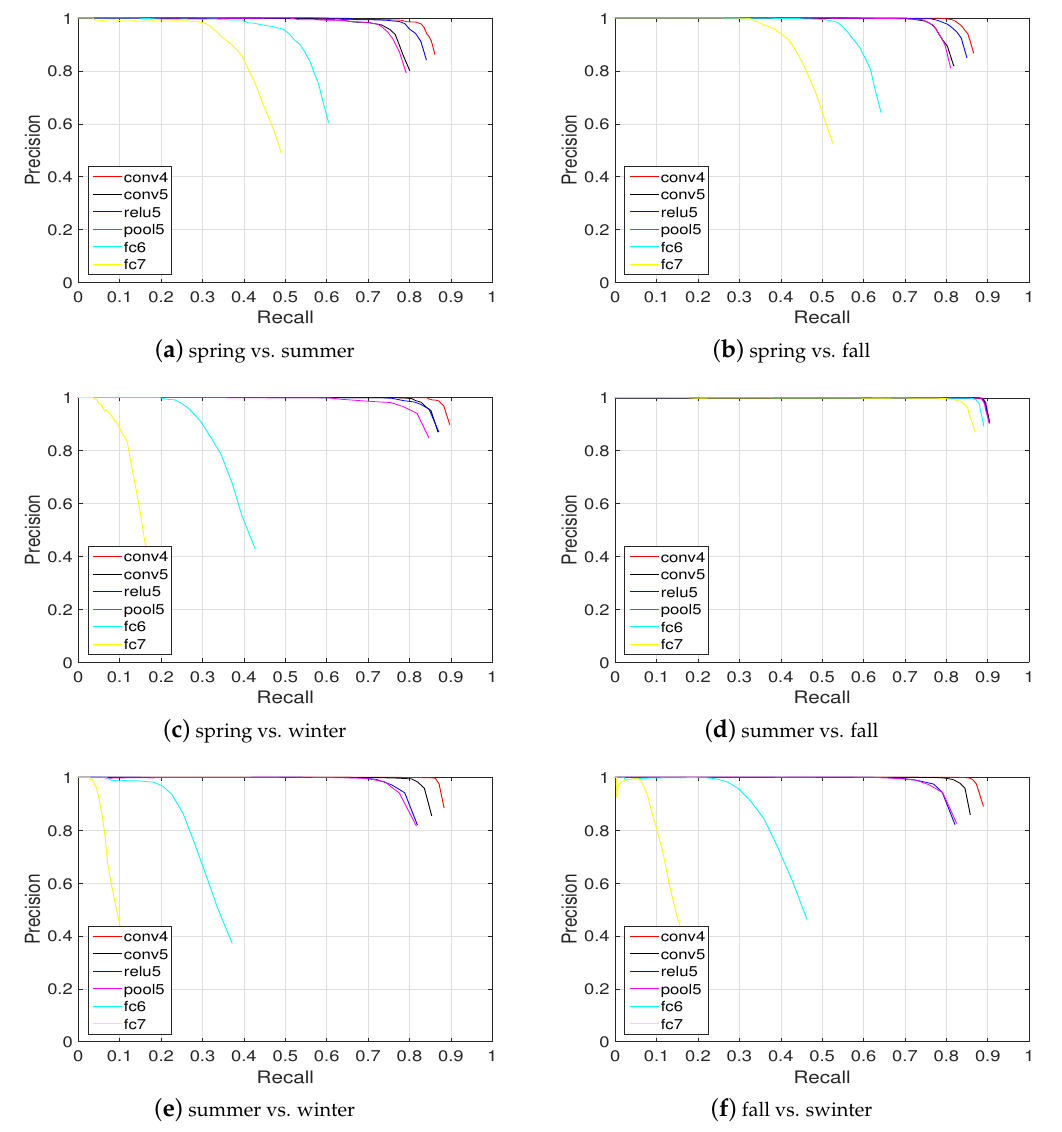
Figure 13. Place recognition across seasons on the Nordland data set. It can be seen that conv4 and conv5 perform better than the others, while fc6 and fc7 are the worst ( d s =